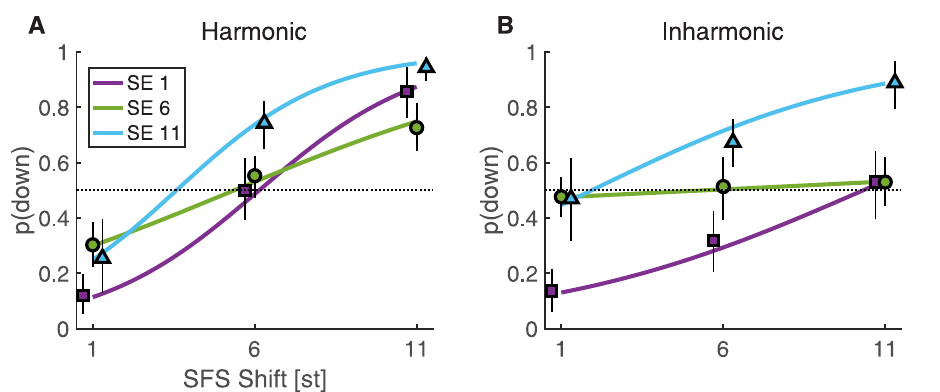
Fig 3. Proportion “down” responses for two-dimensional shifts of Exp. 2 for harmonic (A) and inharmonic (B) Shepard sounds. Colored lines indicate the fixed effects of the GLME model. Black vertical lines indicate 95% confidence intervals obtained by